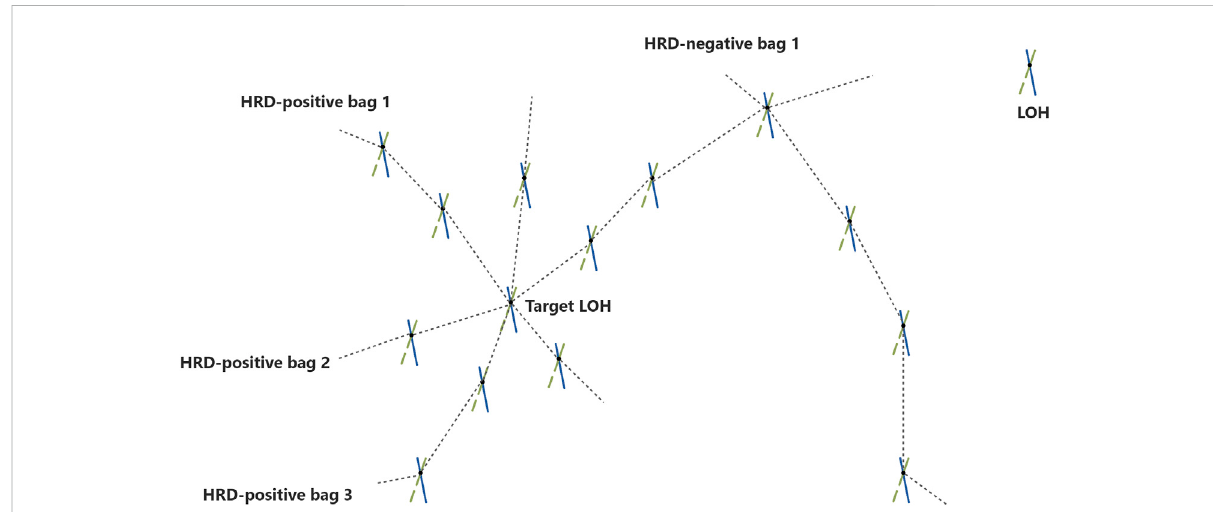
FIGURE 2 The schematic diagram of the target point. Showed in the fi gure, an instance was regarded as a point, and one package had multiple instances. The trajectories of these instances were treated as a manifold. For example, in point A, this intersection should satisfy that every positive package passed through this point, and no negative package passed through this point. So, point A may be a target point.